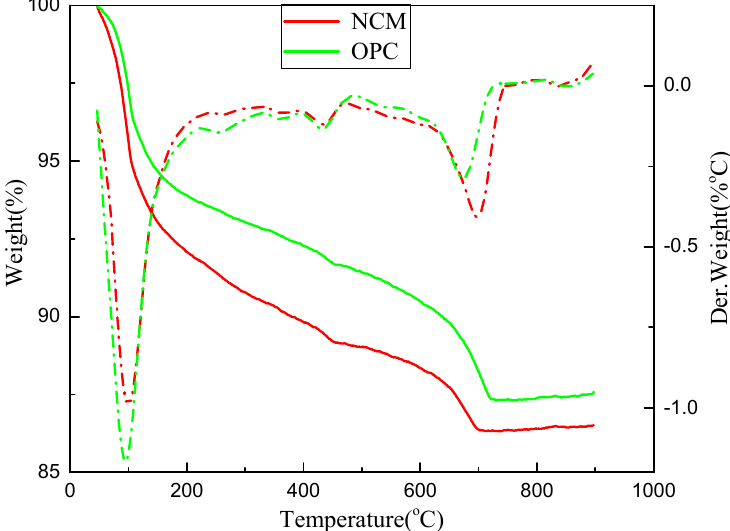
Figure 8. TG/ differential thermal gravimetric (DTG) images of NCM and OPC for 7 days of curing time.